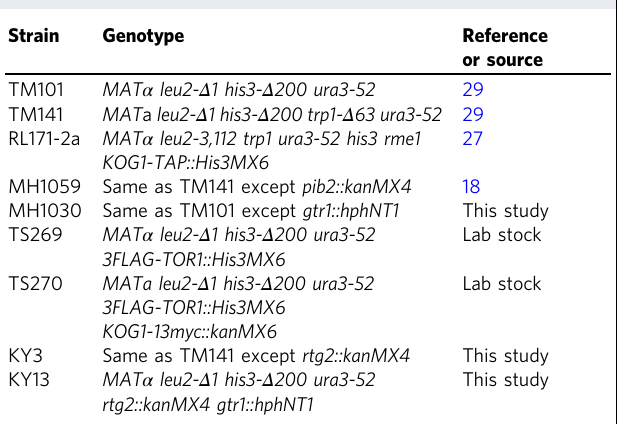
Table 1 Yeast strains used in this